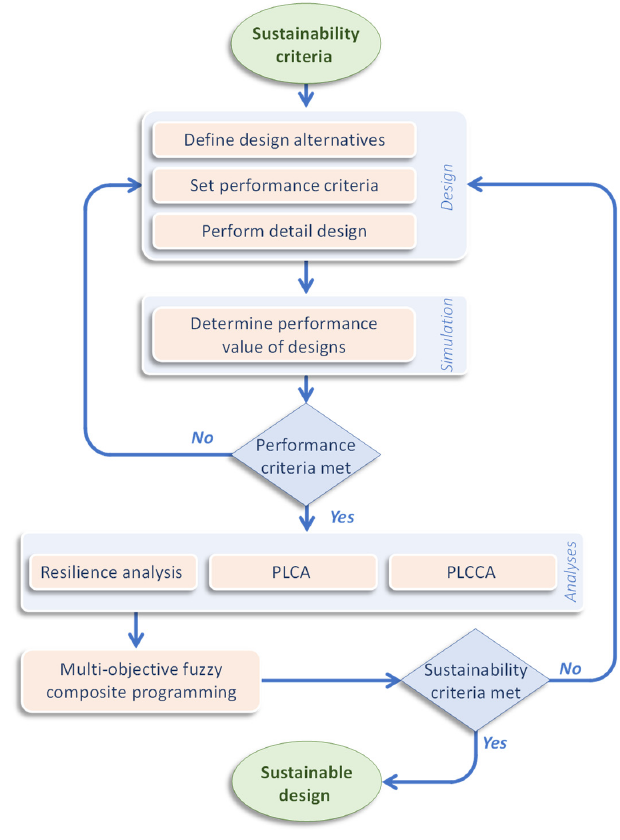
Figure 5. Framework for a design of sustainable flexible pavement. Table 5. Sustainability framework, rating system, indicators, and uncertainty.